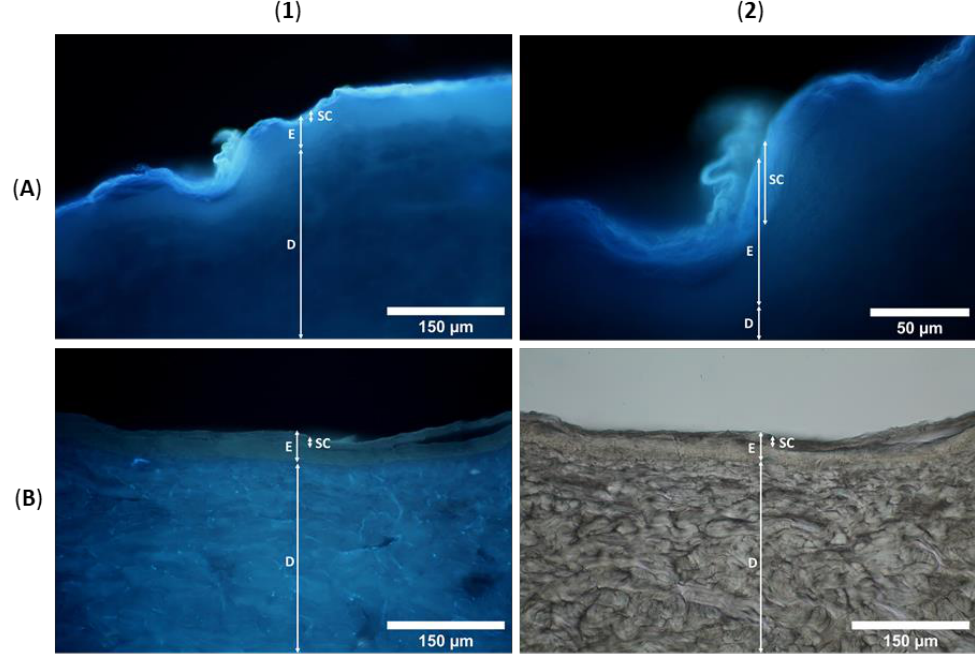
Figure 6. Fluorescence and brightfield microscopic images of minipig skin after treatment with H-DMCA ( A ) and control skin ( B ), SC = stratum corneum , E = epidermis, D = dermis.